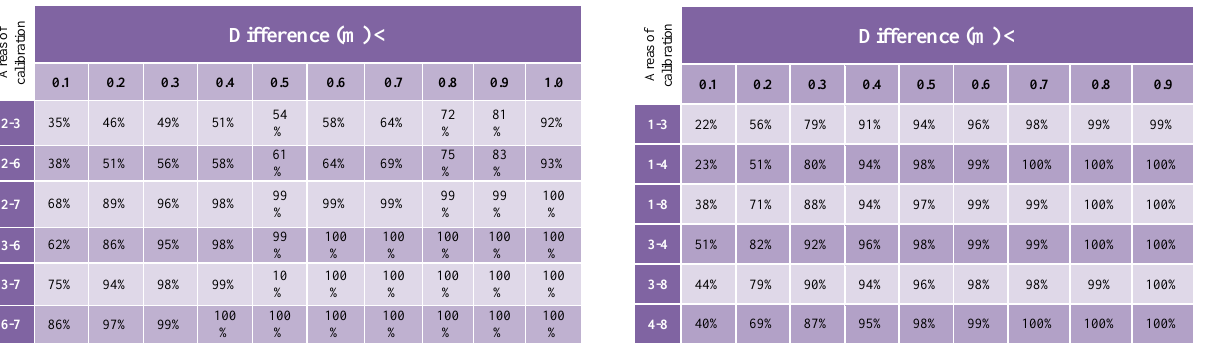
Table 6: Percentiles of the differences between the remaining calibration areas of image 5318 that are lower than the thresholds indicated by the column headers